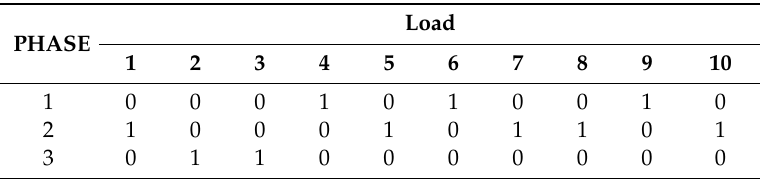
Table 3. Final three-phase connection matrix X ij for load balance with proposed algorithm, corresponding to Figure